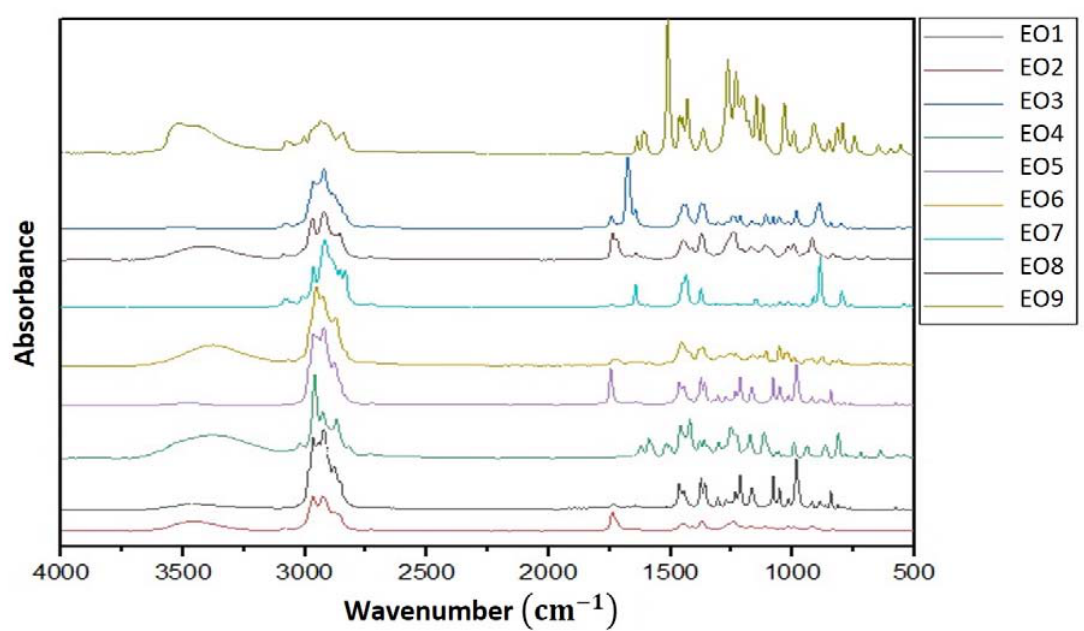
Figure 2. FT-IR spectra of the nine commercial EOs tested: (EO1) E. radiate ; (EO2) L. angustifolia ; (EO3) M. pulegium ; (EO4) O. compactum ; (EO5) R. officinalis ; (EO6) T. vulgaris ; (EO7) C. sinensis ; (EO8) C. aurantium ; (EO9) S. aromaticum.